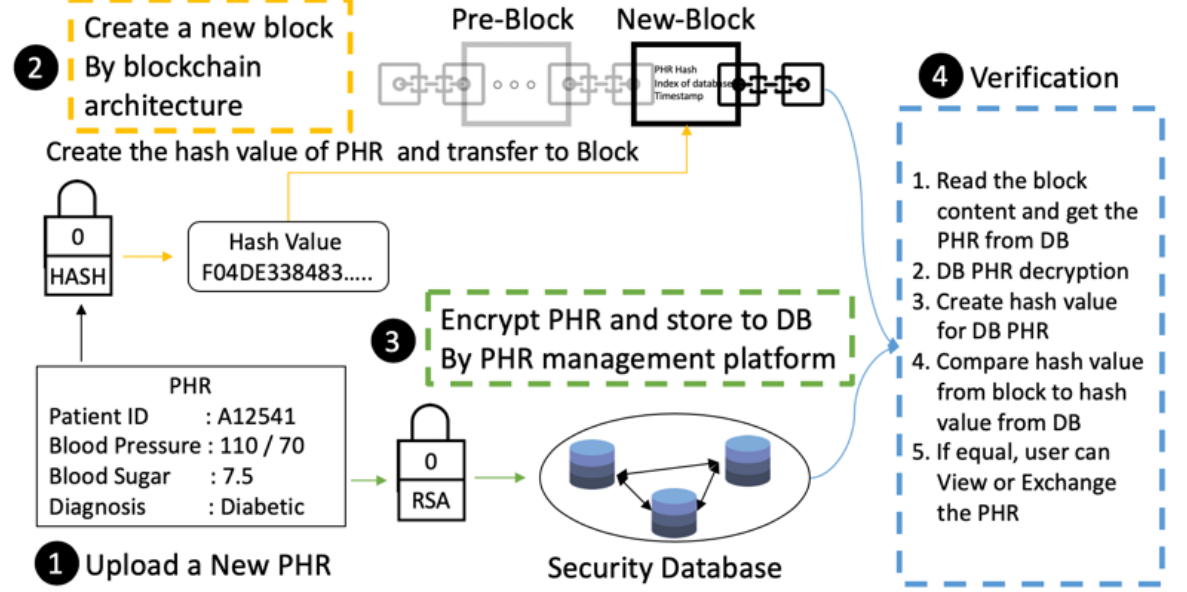
Figure 2. Personal health record creation, uploading, and verification procedure. DB: database; PHR: personal health